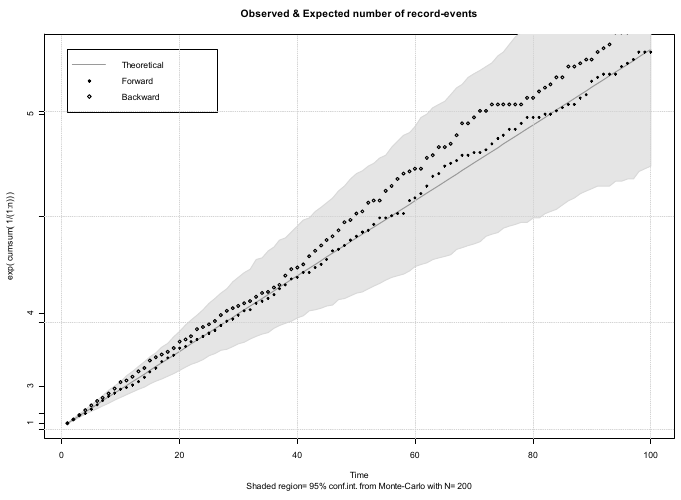
200Time Shaded region= 95% conf.int. from Monte-Carlo with N= Figure 11 – Relationship between the theoretical and empirical data in